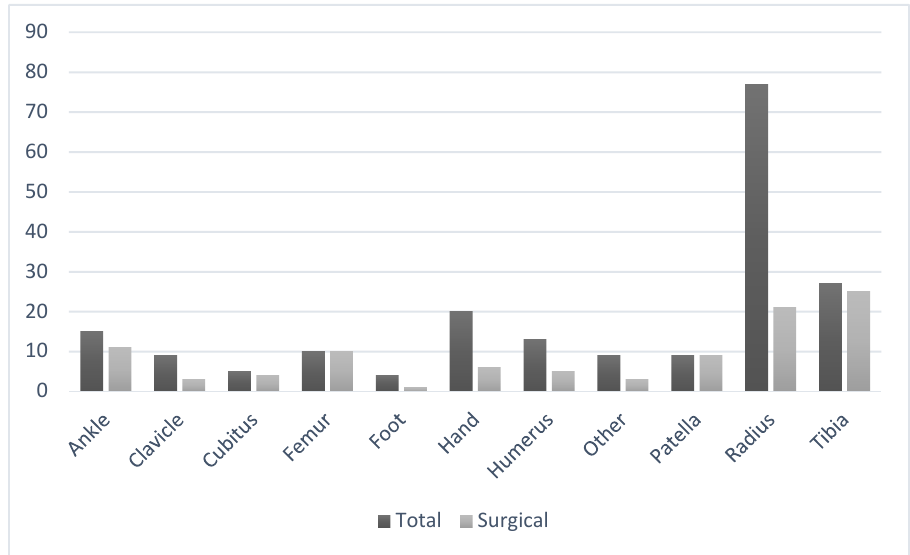
Figure 2. Although most fractures were produced on radius, lower limb fractures were more commonly treated by surgery. In ‘other’ fractures were included 1 acetabular injury, 4 costal fractures, 2 vertebral fractures and 2 mandibular fractures.